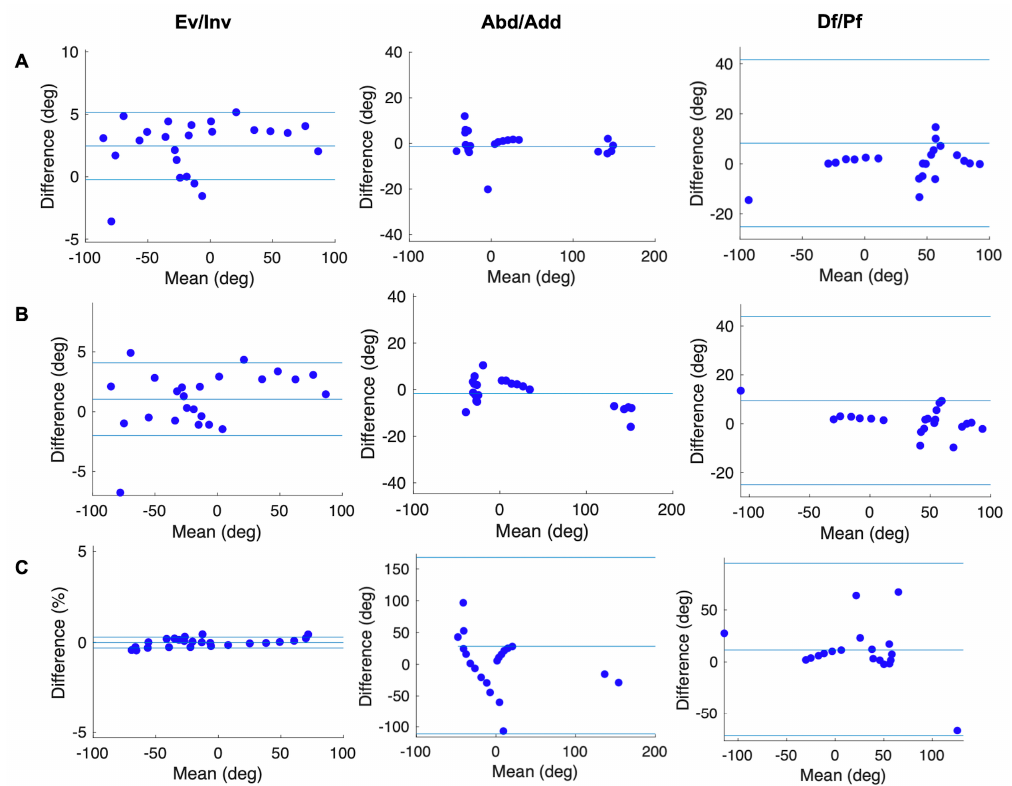
Figure 8. Bland–Altman plots showing the di ff erence between the true values of the Cal_Met angle and the Cal_Met angle calculated according to the three models; ( A ) our new model, ( B ) our new model_2, and ( C ) the Rizzoli model, against their means. When they do not have either a fixed or proportional bias, the mean is shown (one blue solid line). When they have fixed or proportional biases, the mean (the middle one of three blue solid lines) and limits of agreement are shown (the outer two of three blue solid lines). When they have a proportional bias, the di ff erence (Y-axis) calculates the relative value to the mean